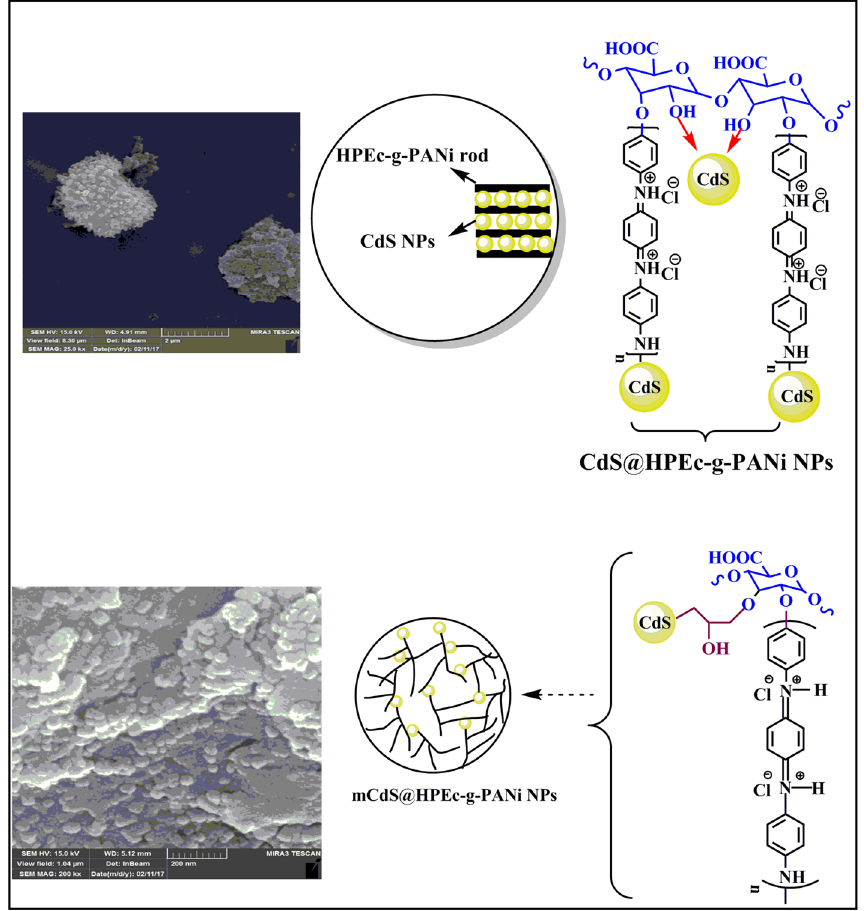
Figure 6. The schematic representation of synthesized nanostructures with morphology